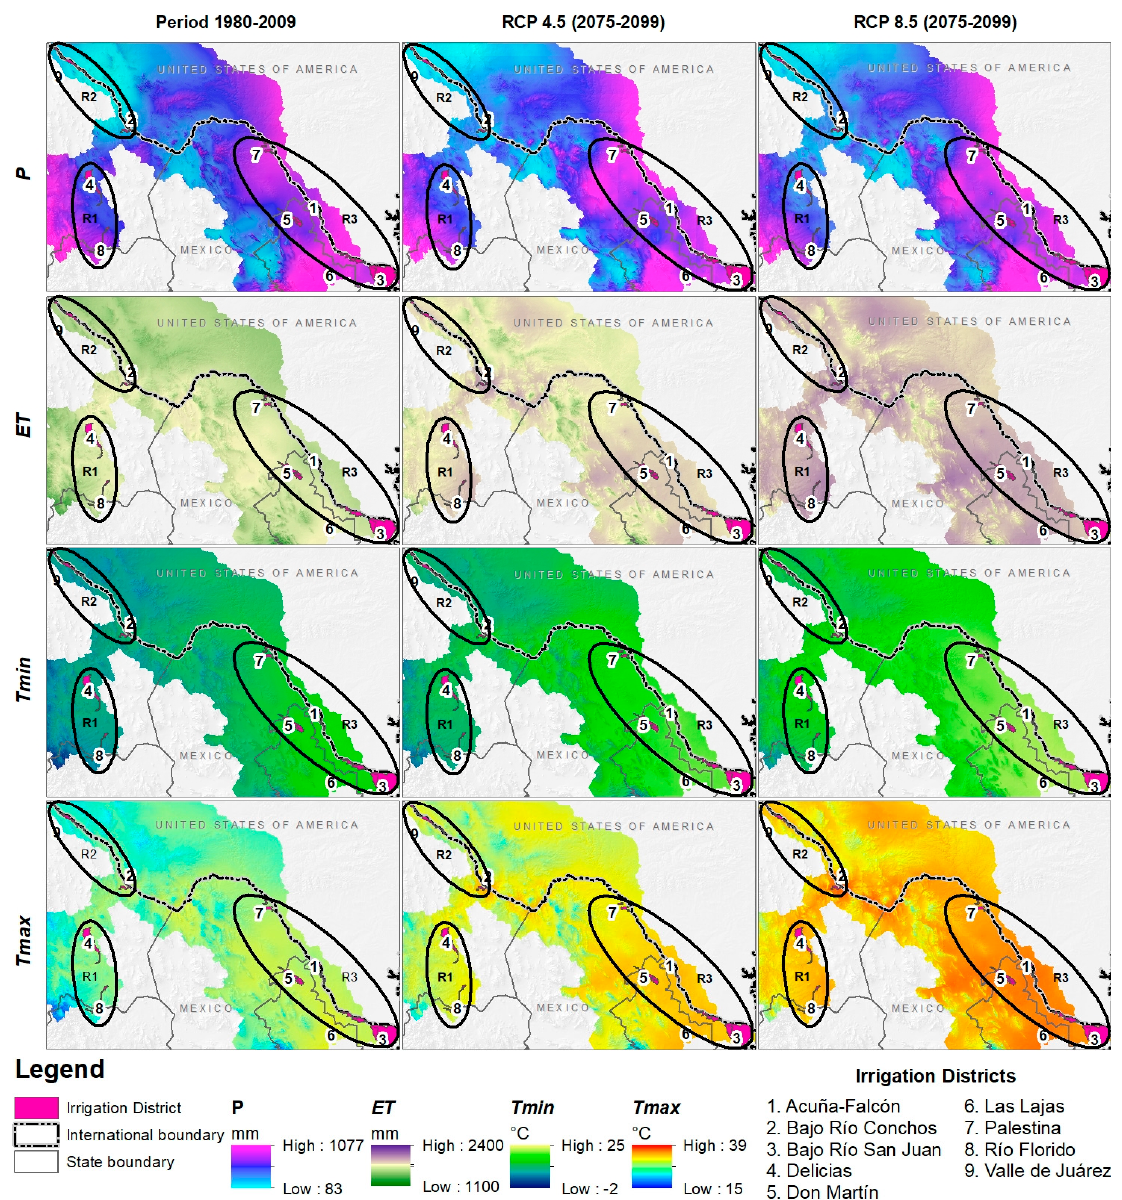
Figure 7. Spatial changes of average annual precipitation ( P ), evapotranspiration ( ET ), minimum temperature ( Tmin ), and maximum temperature ( Tmax ) for the 1980–2009 base scenario and for the 2075–2099 period under the RCP4.5 and RCP8.5 climate change scenarios in the Rio Bravo Basin.